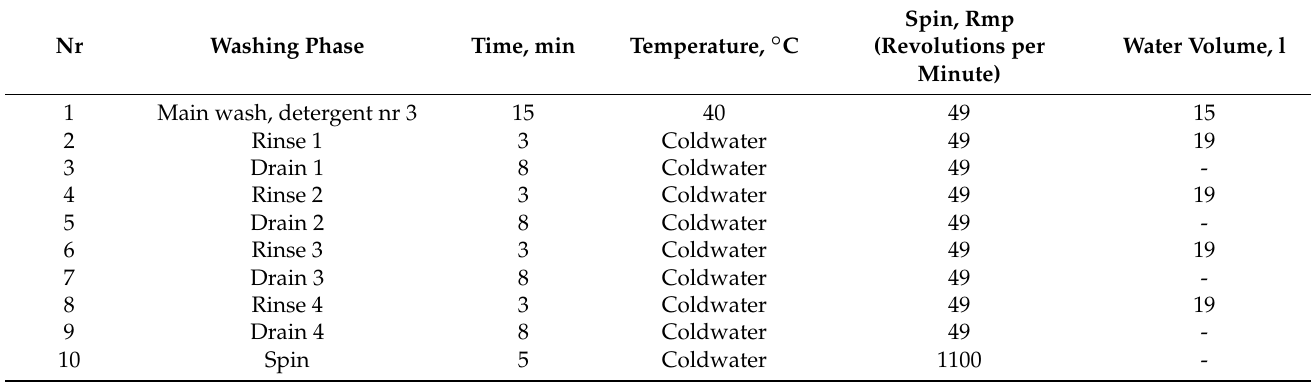
Table 4. Washing test procedure overview based on ISO 6330-2012